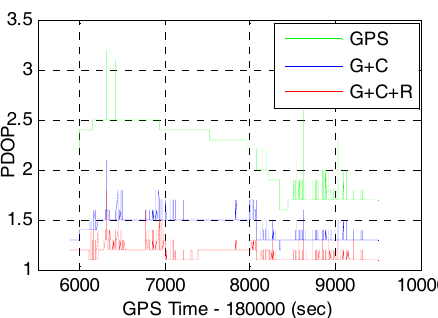
Figure 5. PDOP of GPS (G), GPS/BDS (G+C), GPS/BDS/GLONASS (G+C+R) with 15° cut-off elevation angle.